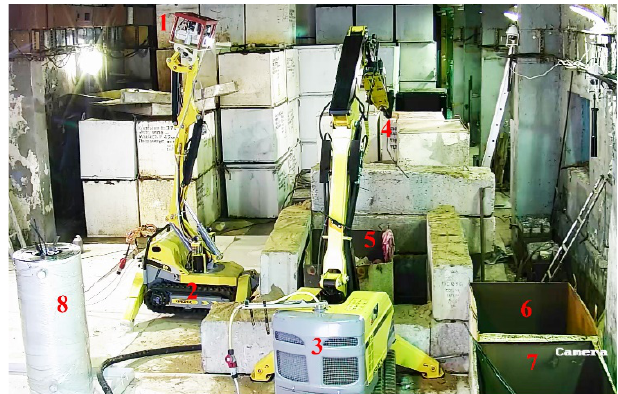
Fig.3. The location of the equipment during the measurements of the rods activity in the proccess of sorting radioactive waste. 1 – measuring part of system “Gamma-Pioneer”, 2 – Brokk-90 robot, 3 – Brokk-160 robot, 4 – rod fragment, 5 – inspected container, 6 – construction waste conteiner, 7 – low level waste container. 8 – transport container for high level